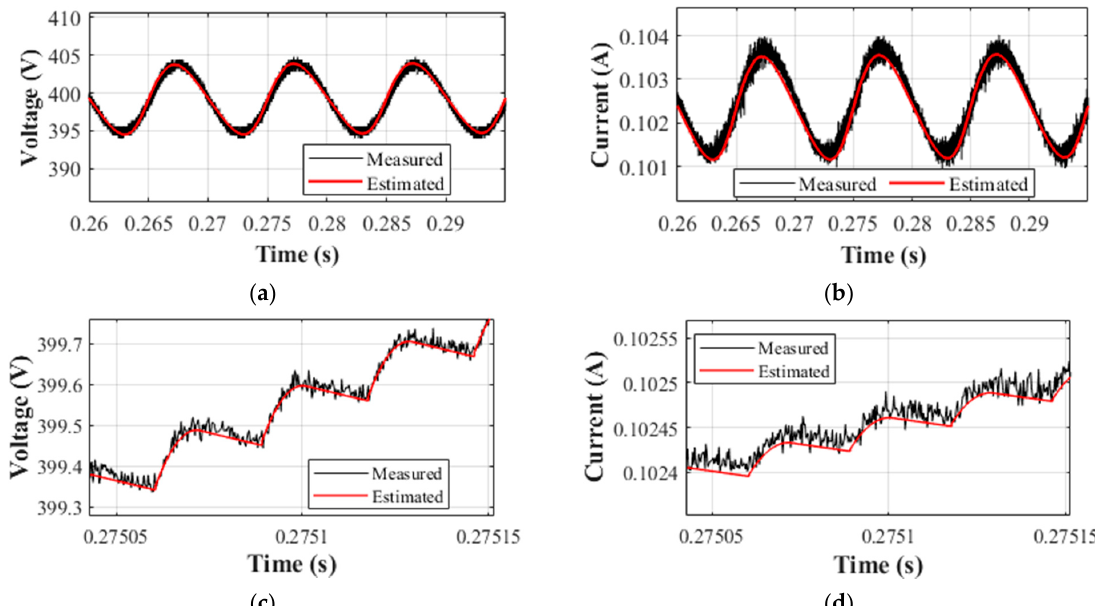
Figure 15. Experimental versus simulated data of the boost converter: ( a ) Output voltage (the timespan was three periods of AC source frequency); ( b ) output current (the timespan was three periods of AC source frequency); ( c ) output voltage (the timespan was three periods of the PWM switching frequency); ( d ) output current (the timespan was three periods of the PWM switching frequency).